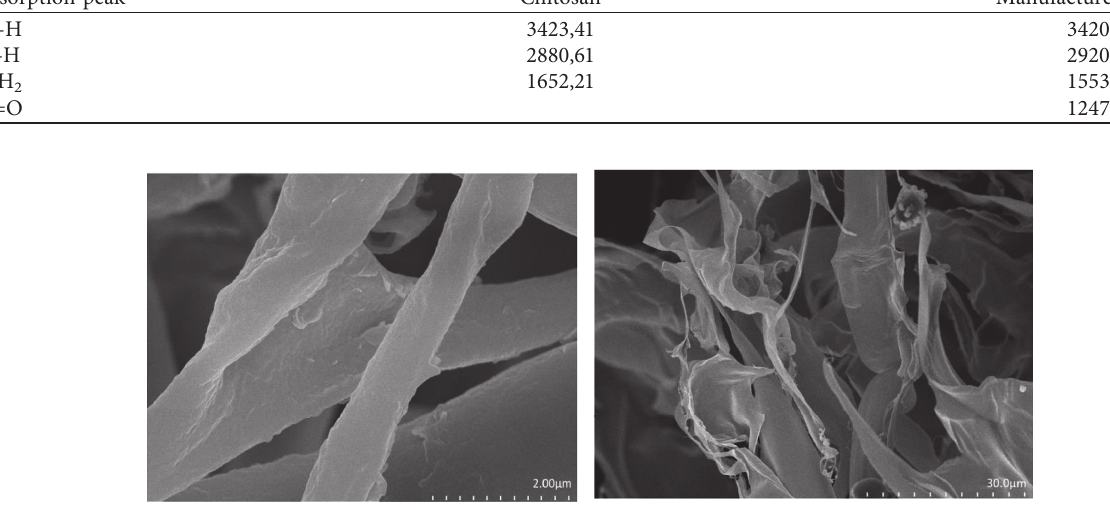
Figure 9: FE-SEM of original chitosan used for research.